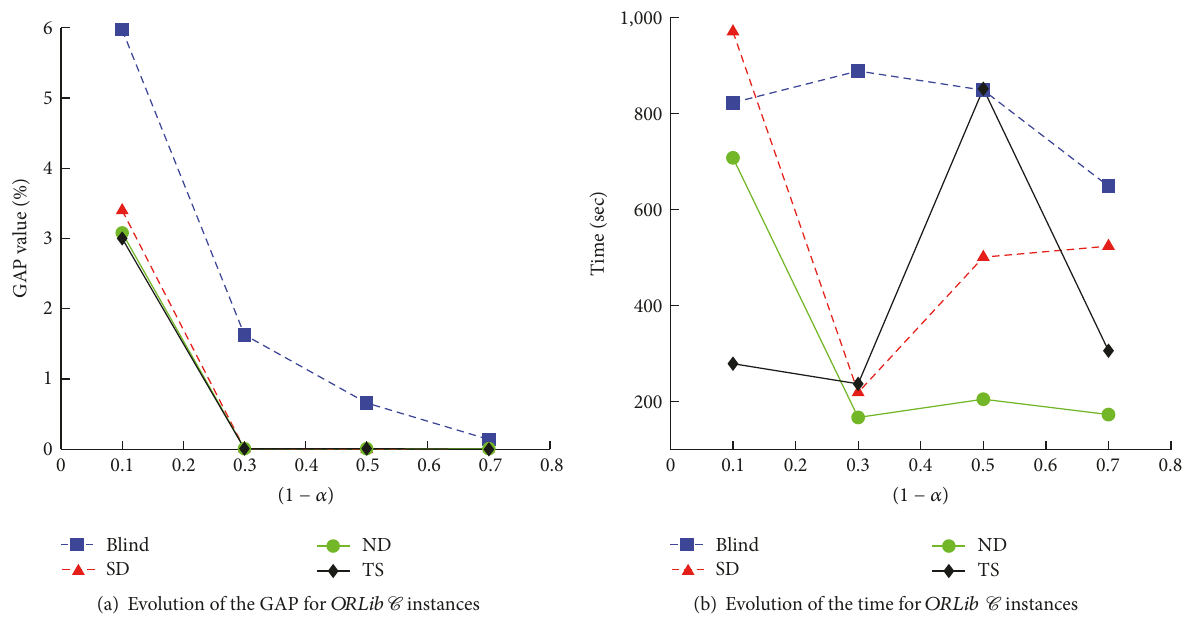
Figure 6: Average results obtained by the local search algorithms for each value of (1 − 𝛼) for 𝑂𝑅𝐿𝑖𝑏 C instances.